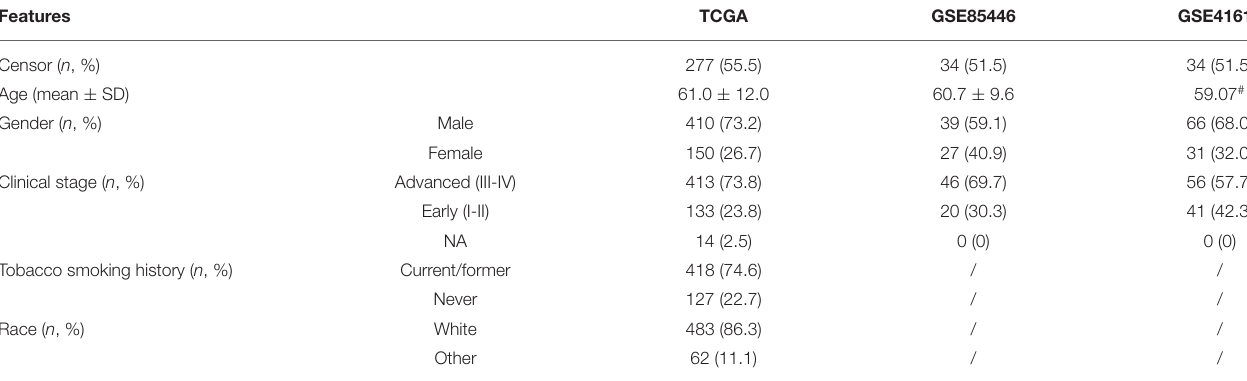
TABLE 1 | Detailed information of the training and validation datasets.